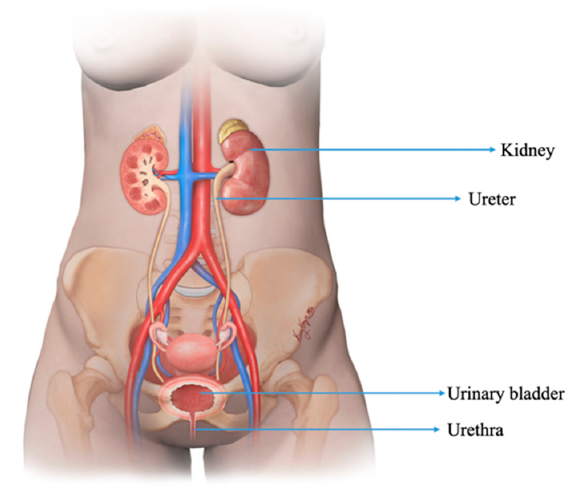
Figure 1. Illustration demonstrating the structures of the normal female genitourinary tract.